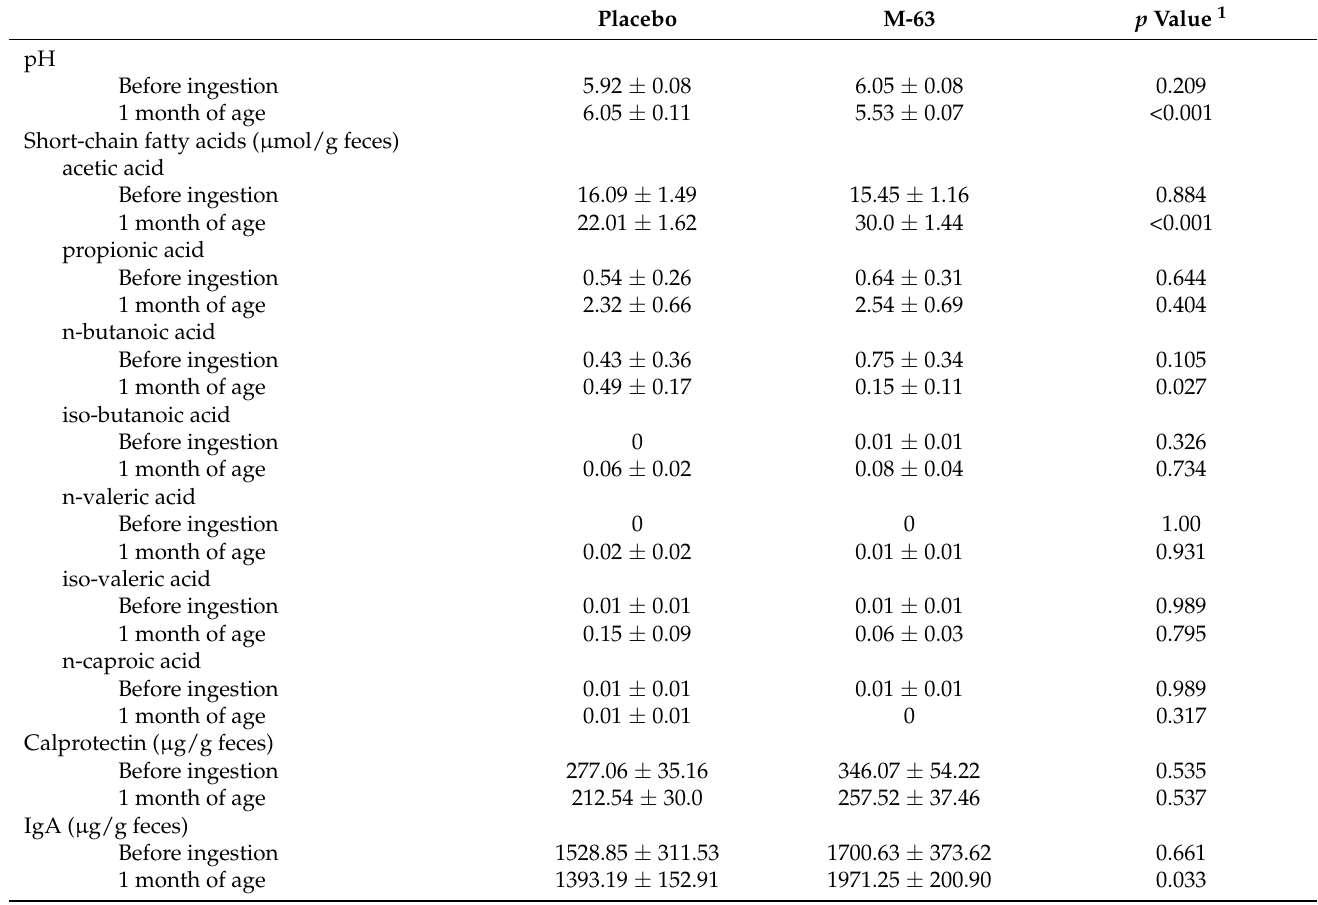
Table 4. pH, amount of short-chain fatty acid, IgA, and calprotectin in the stools. Placebo M-63 p Value